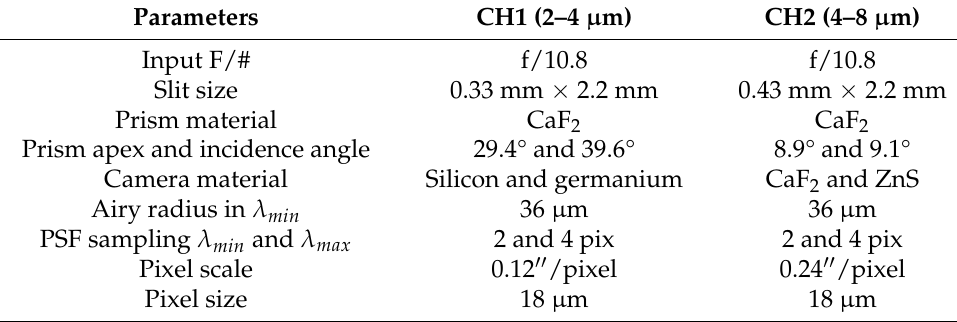
Table 7. Summary of optical parameters of infrared